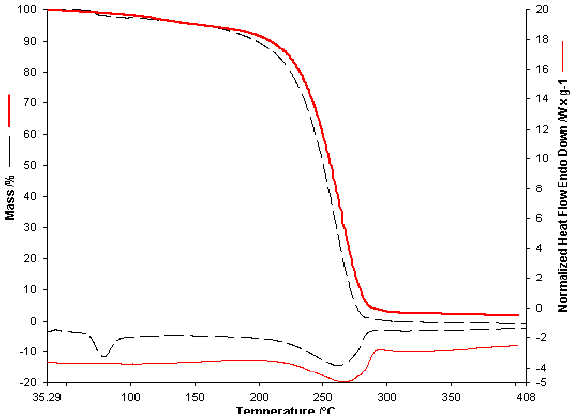
Figure 5. The thermoanalytical curves of L (SA)-- - - and L (D)___ obtained with a heating rate of 10 °C ∙ min − 1 .